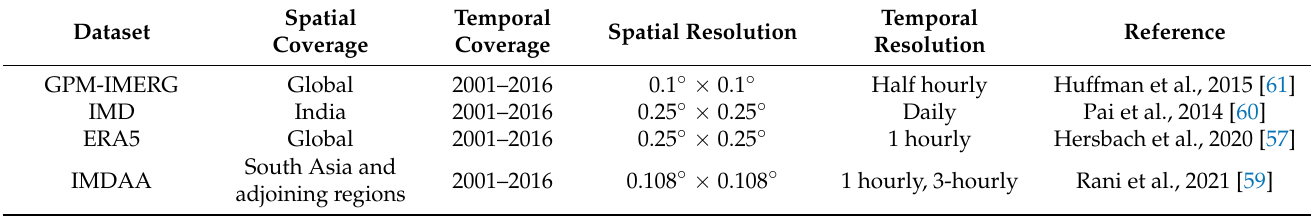
Table 2. Various datasets used in this study, along with their spatial and temporal